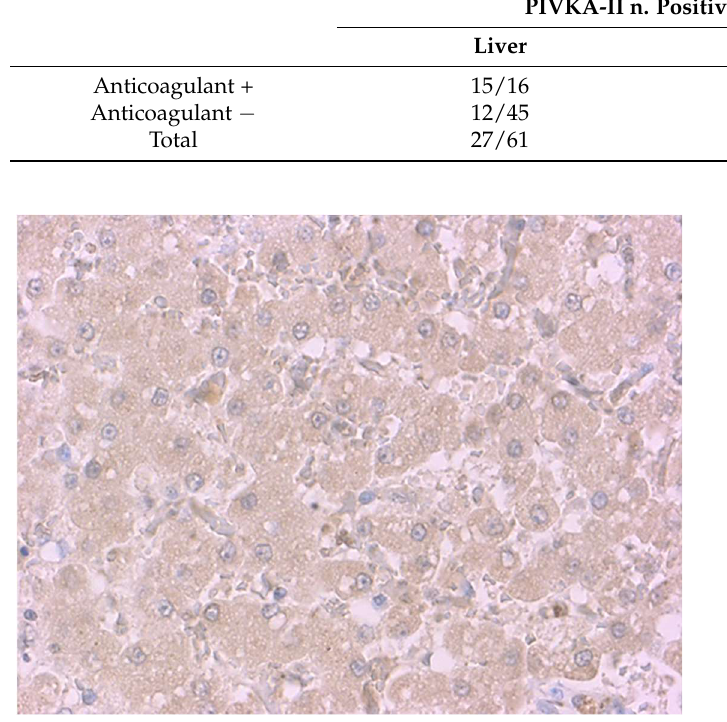
Figure 1. Liver of a dog after PIVKA-II immunostaining. Positive diffuse cytoplasmic immunoreactivity within hepatocytes. PIVKA-II immunohistochemistry, Mayer’s hematoxylin counterstain, and 40× objectives.